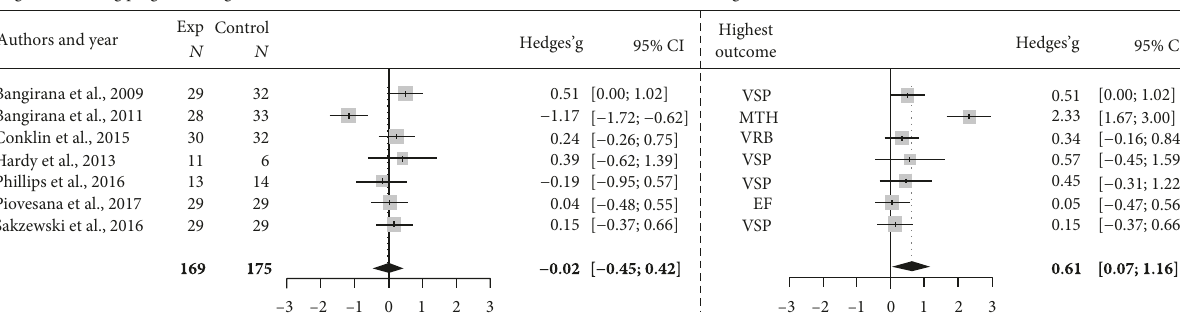
Figure 2: Forest plots showing the number of participants per group, e ff ect size estimates (Hedges ’ s g ), and 95% con fi dence interval of each study, comparing cognitive training outcomes with control condition ’ s outcomes. Model Cognitive A depicts the meta-analytic model that considers, for each study, a combined mean value representing the mean value of multiple outcomes relative to all cognitive domains. Model Cognitive B depicts the meta-analytic model that considers, for each study, the highest outcome domain. Note: VSP =visuo-spatial skills; MTH=math; VRB =verbal; EF=executive